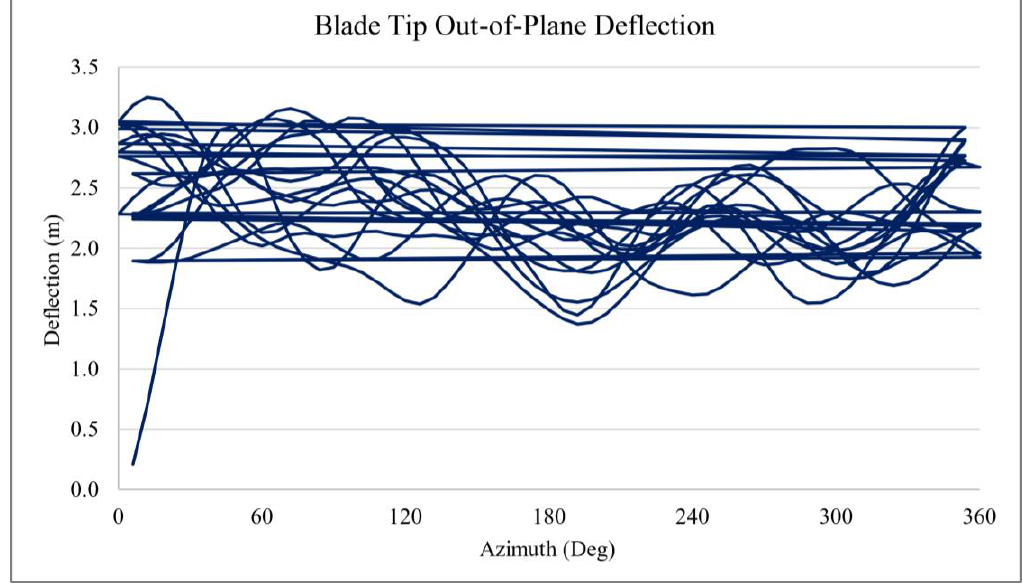
Figure 10. Blade Tip Out-of-Plane Deflection with Azimuth Angle - 25% Turbulence Intensity